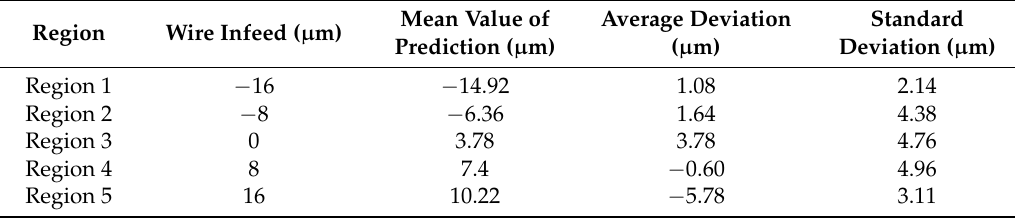
Table 4. Accuracy of the prediction of the deep neural network as a function of wire infeed.